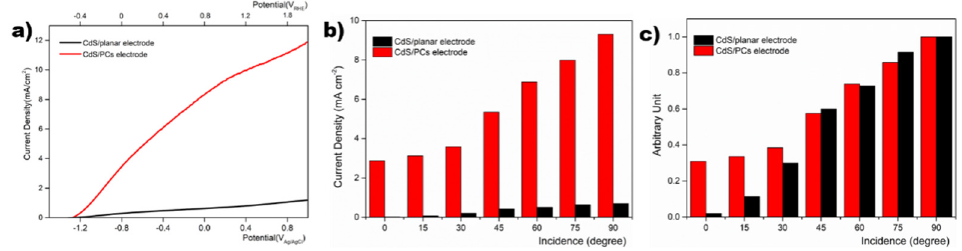
Figure 4. ( a ) LSV curves of CdS-loaded CdS/PC FTO and CdS/planar FTO photoelectrode; ( b ) current density of CdS/PC FTO and CdS/planar FTO photoelectrode under incidence from 90° to 0°; ( c ) the relative current density in comparison to that under 90° illumination.